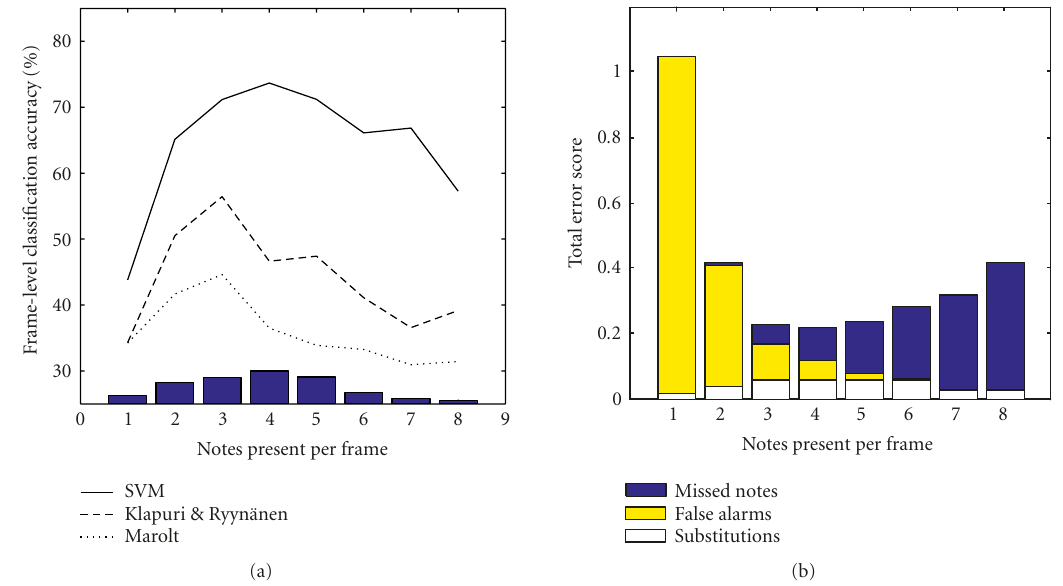
Figure 5: (a) Variation of classification accuracy with number of notes present in a given frame and relative note frequency. (b) Error score composition as a function of the number of notes present.